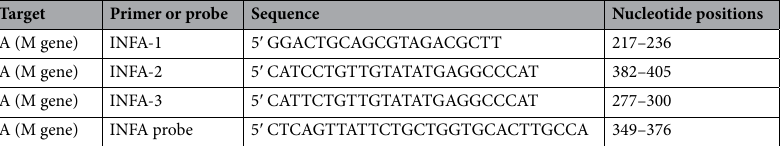
Table 1. Selected primers and probes for TaqMan amplification of viral RNA from Influenza A H1N1